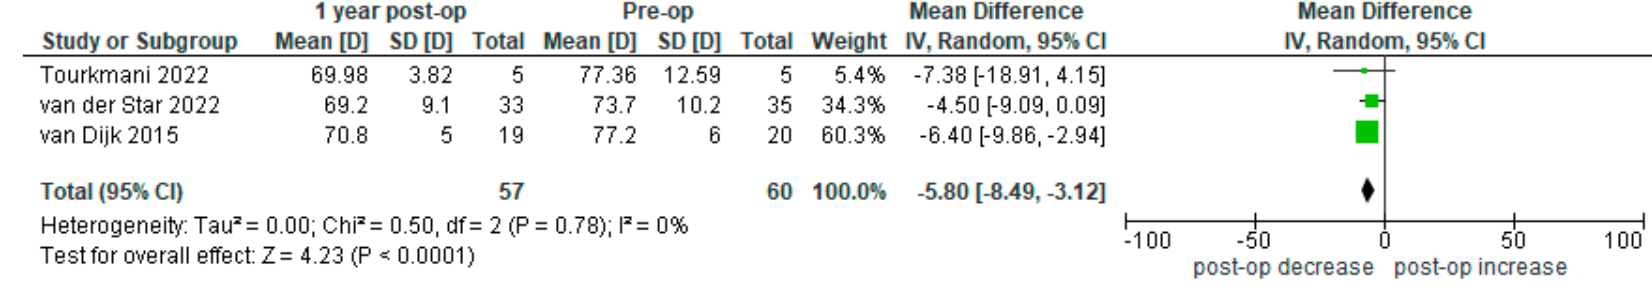
Figure A17. Difference in maximum keratometry across 3 studies [32,37,43]. Figure A17. Di ff erence in maximum keratometry across 3 studies [32,37,43]. Figure A17. Di ff erence in maximum keratometry across 3 studies [32,37,43].